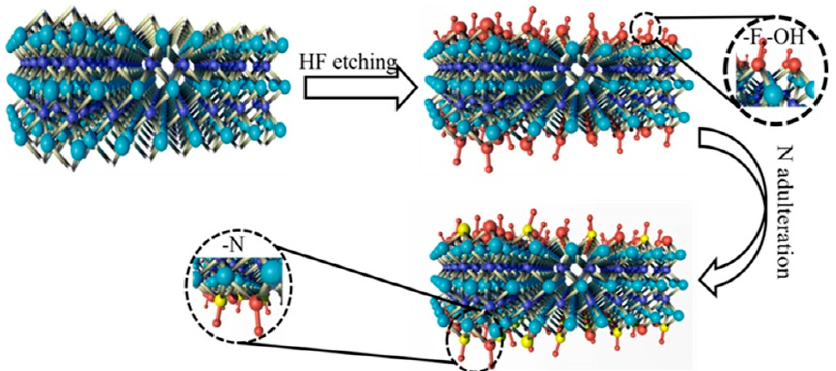
Figure 2. Schematic diagram of the synthetic structure of N − Ti 3 C 2